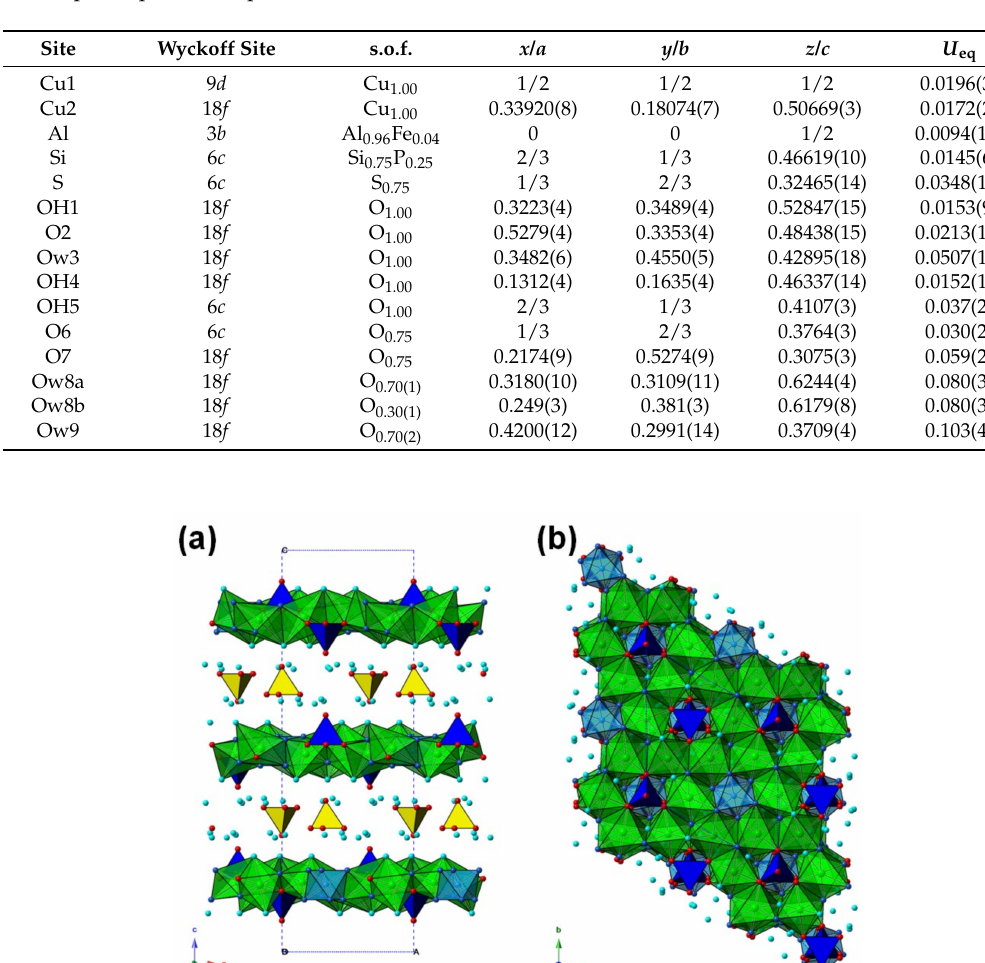
Table 4. Site labels, Wyckoff sites, site occupancy factor (s.o.f.), atom coordinates, and equivalent isotropic displacement parameters (Å 2 ) for tiberiobardiite.